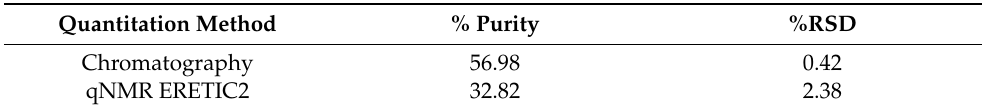
Table 1. Results of the purity evaluation of the isolated hepatodamianol using a chromatographic- based procedure and qNMR ERETIC2 tool (based in PULCON method). The % average value of purity is shown, n = 3